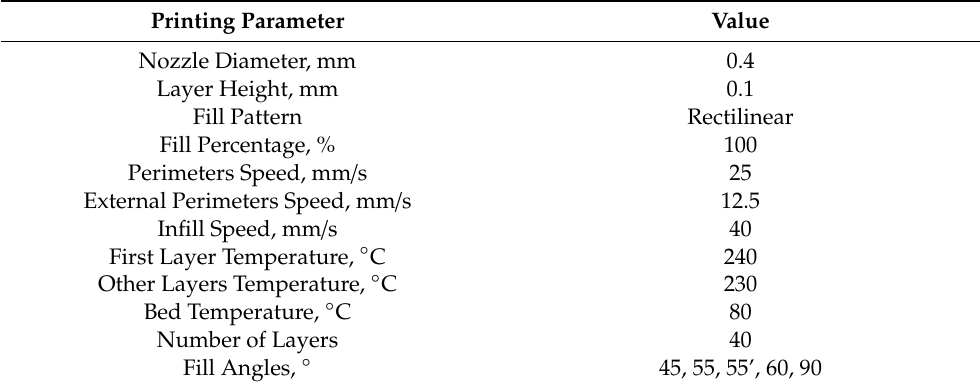
Table 1. Parameters of the 3D printing